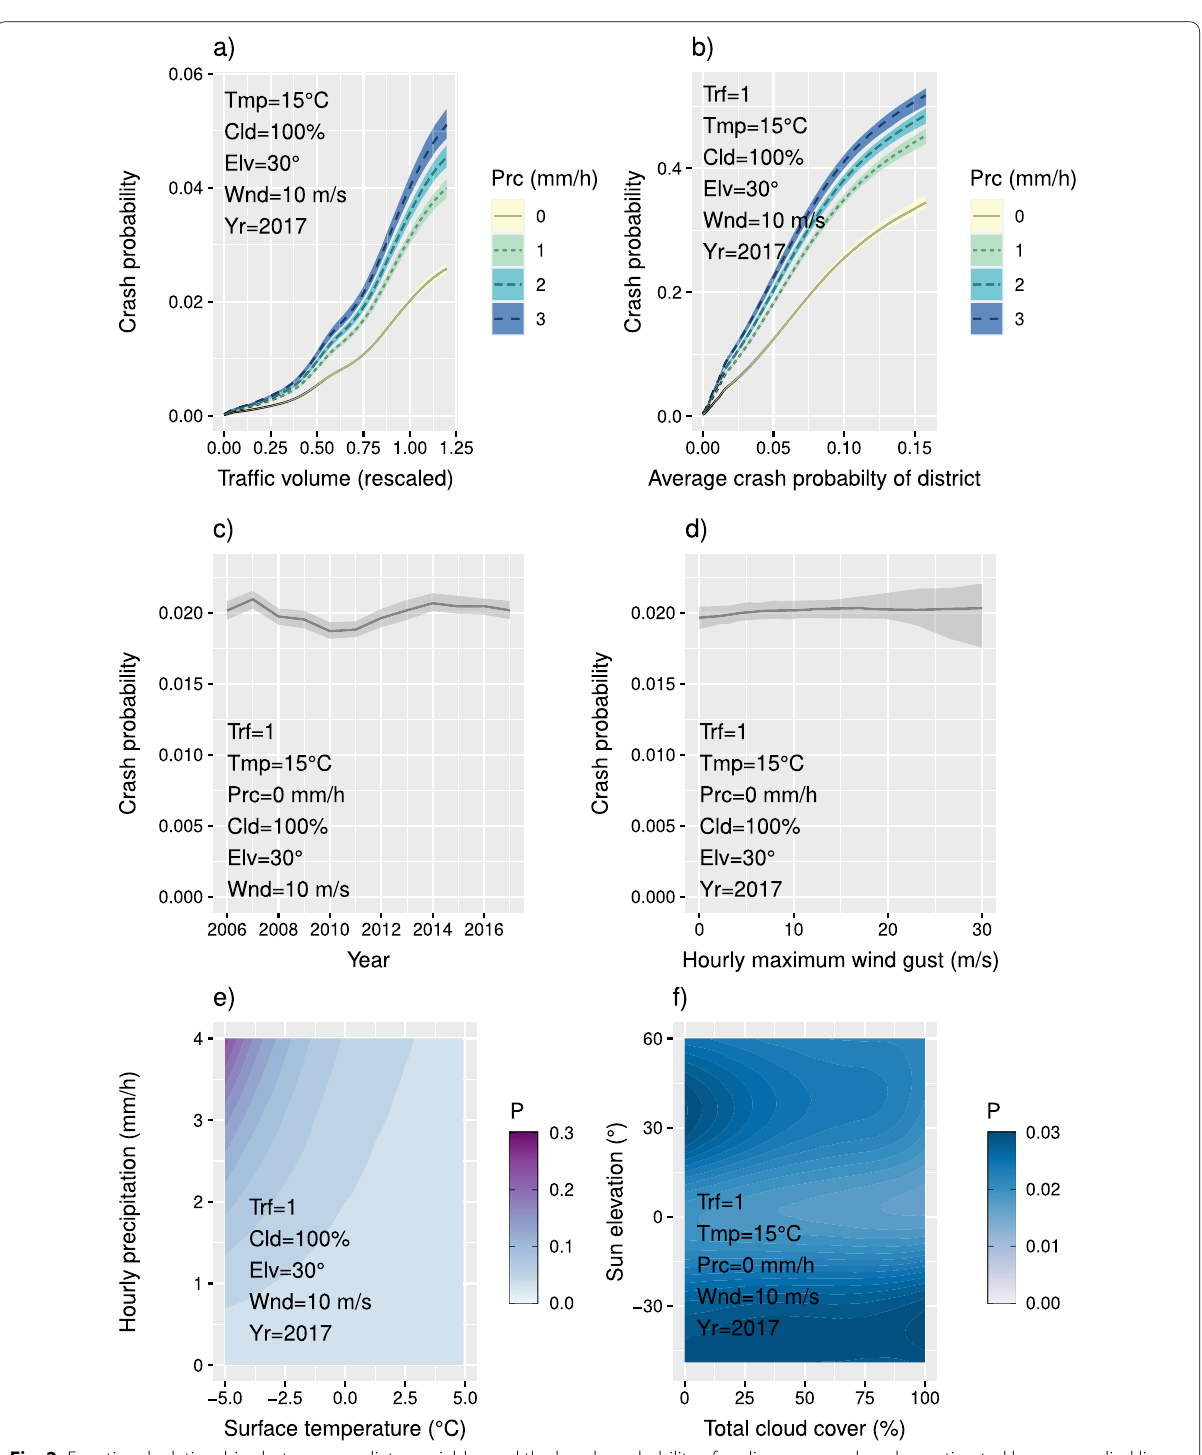
Fig. 2 Functional relationships between predictor variables and the hourly probability of muli-car rear-end crashes estimated by a generalied linear model. 95% confidence intervals (shaded areas) are estimated from 100 models fitted with randomly drawn training